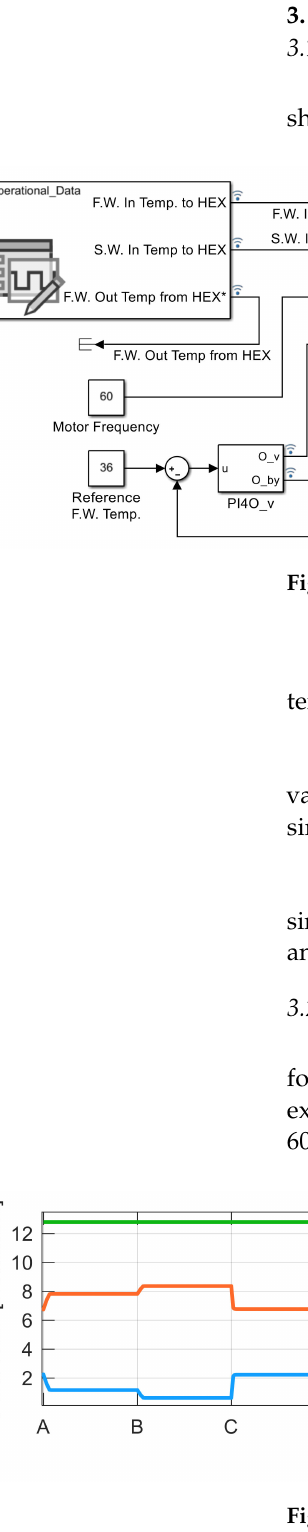
Figure 9. Simulation FW and SW flow